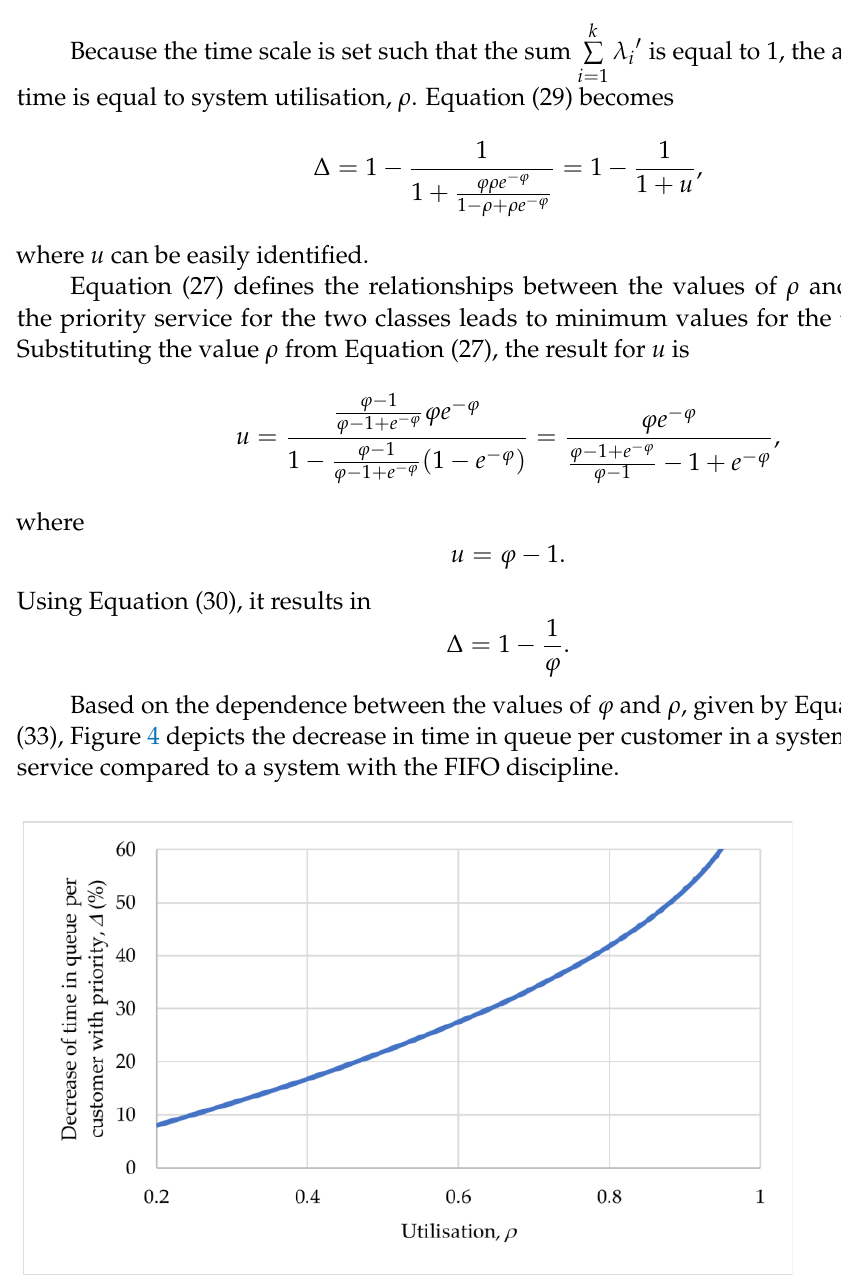
Figure 4. Decrease in time in queue per customer in a system with priority service compared to a system with the FIFO discipline. system with the FIFO